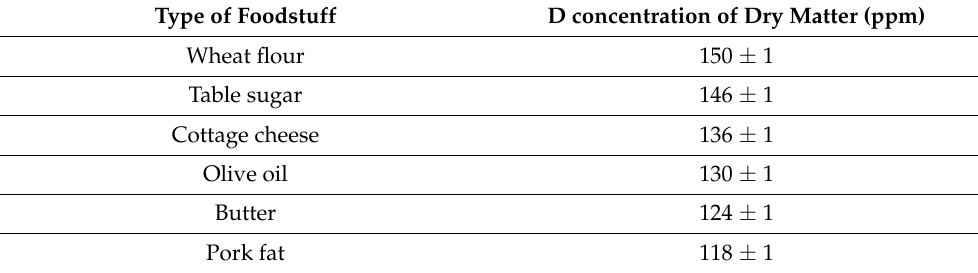
Table 4. D concentration of the dry matter of different foods.